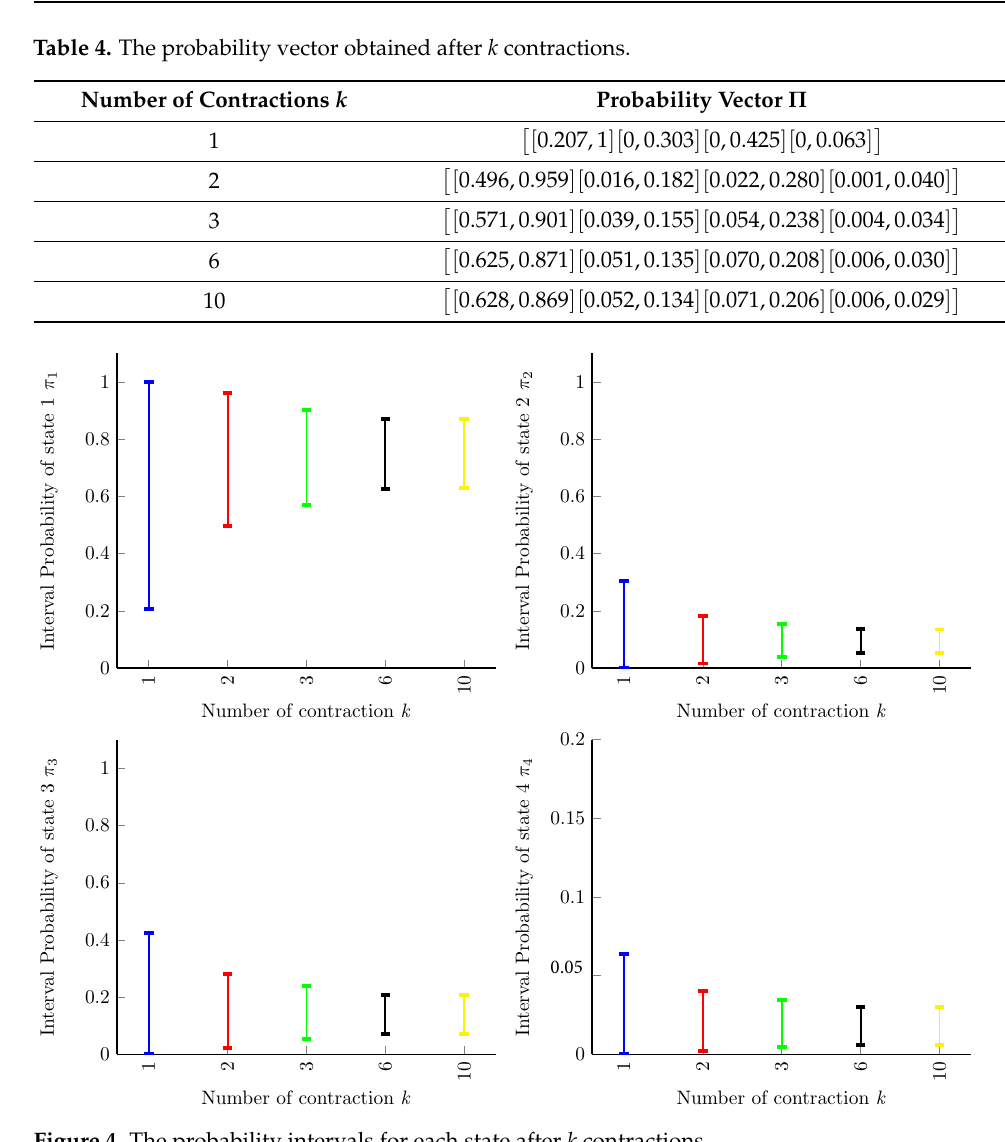
Figure 4. The probability intervals for each state after k